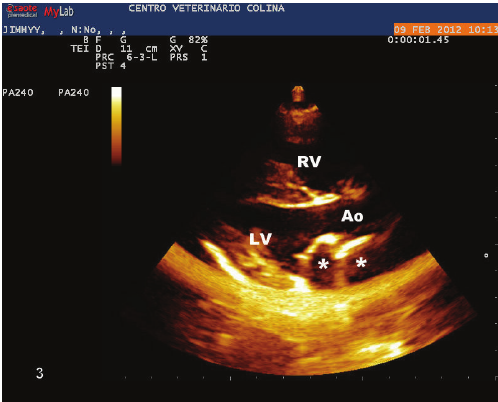
Figure 3: The transthoracic two-dimensional echocardiogram (parasternal long-axis view). Note a transverse membrane subdi- viding the left auricle into two distinct chambers ( ∗ ), one proximal and one distal, the classical anatomic presentation of CTS. Right ventricle (RV), left ventricle (LV), and aorta